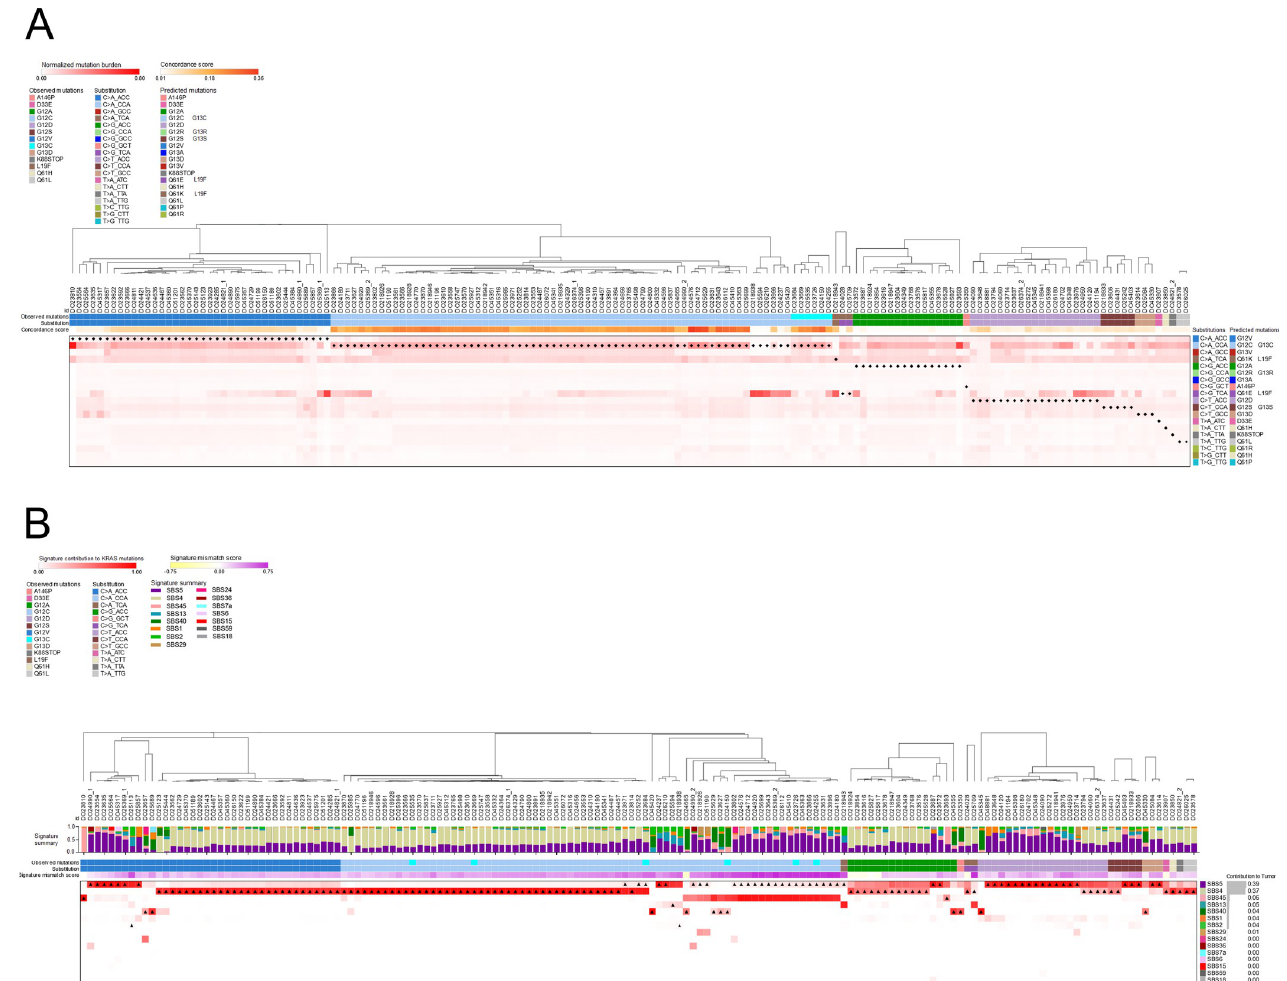
Fig 5. Multifactorial processes determine the type of KRAS mutations observed in human lung adenocarcinomas. ( A ) Heatmap of the mutation burden for substitutions matching KRAS oncogenic mutations in human lung adenocarcinomas estimated from the mutation signatures active in these tumors and normalized to per tumor proportions. Black diamond indicates the substitution type matching the KRAS mutation in that tumor. The KRAS mutation and the substitution type for the KRAS mutation for each tumor were shown below the donors. Concordance score reflects the degree of concordance between the most likely KRAS mutation predicted by the estimated mutation burden and the actual KRAS mutation observed in that tumor. ( B ) Heatmap of the contribution of mutation signatures to KRAS mutations detected in human lung adenocarcinomas. Black triangles indicate the dominant mutation signature in that tumor measured by contribution to total mutation burden. Signature summary displays the contribution of mutation signatures to total mutation burden in each tumor. The KRAS mutation and the substitution type for the KRAS mutation for each tumor were shown below the signature summary. Signature mismatch score reflects the degree of the discordance between the contribution to mutations overall and the contribution to KRAS mutation alone for the mutation signature most responsible the KRAS mutation observed in that